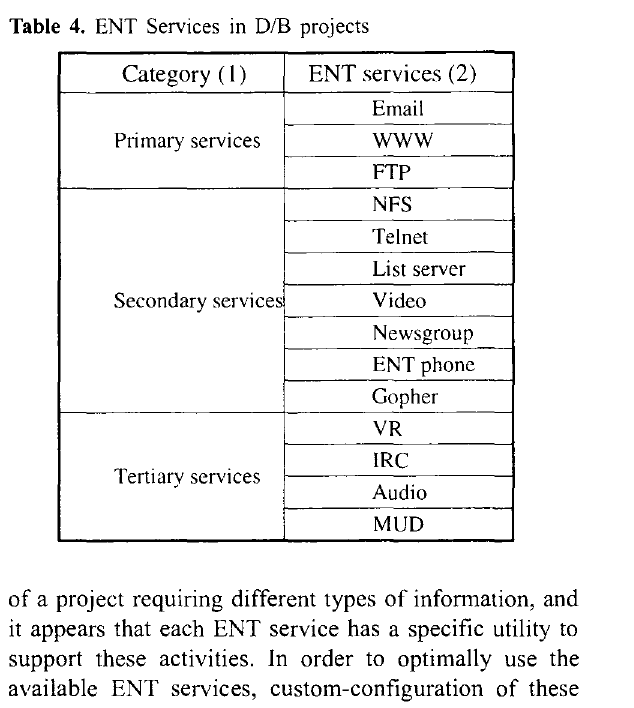
Table 4. ENT Services in D/B